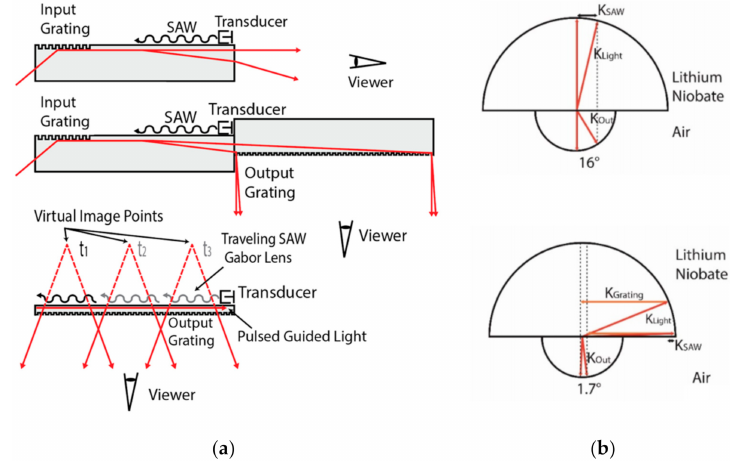
Figure 10. ( a ) Leaky mode near-eye display with edge exit (top) and fabricated bottom surface exit (middle). Proposed example of monolithic near-eye display (bottom). ( b ) K-vector picture of output from an edge-emitting device (above) with no grating and a bottom-exit device with a large fixed grating (below). The output angle in the latter case is dramatically reduced. Reprinted with permission from [18] © The Optical